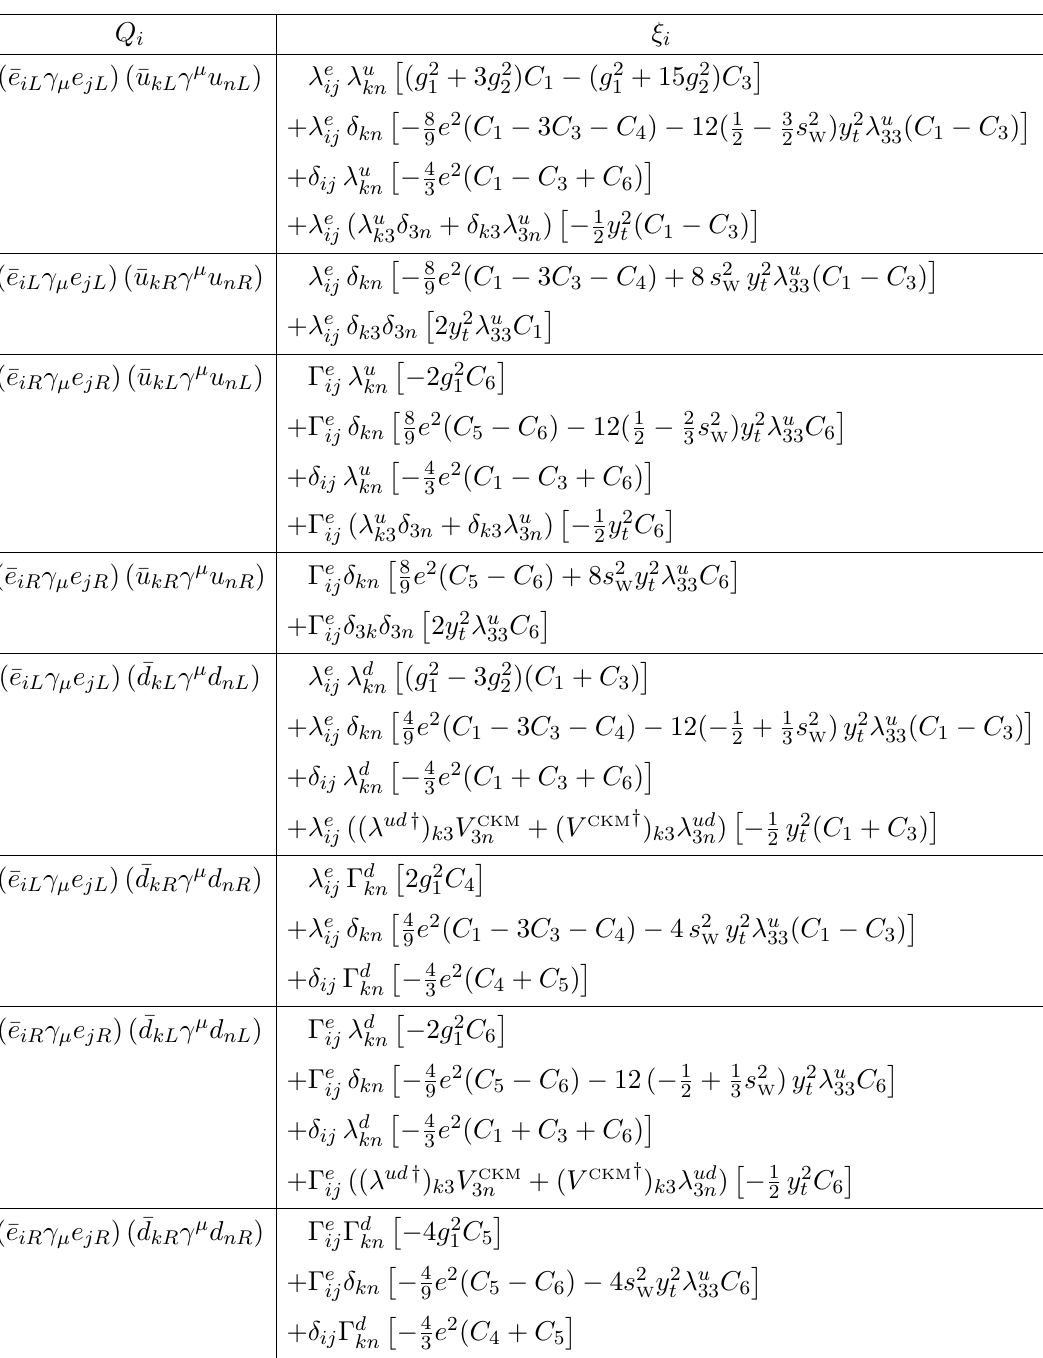
Table 4 . Operators Q i and coe(cid:14)cients (cid:24) i for the semileptonic part of the e(cid:11)ective Lagrangian L EW involving charged leptons and neutral currents. Generation indices run from 1 to 3, exception made for up-type quarks where k; n = 1 ; 2. We set sin 2 (cid:18) W (cid:17) s 2